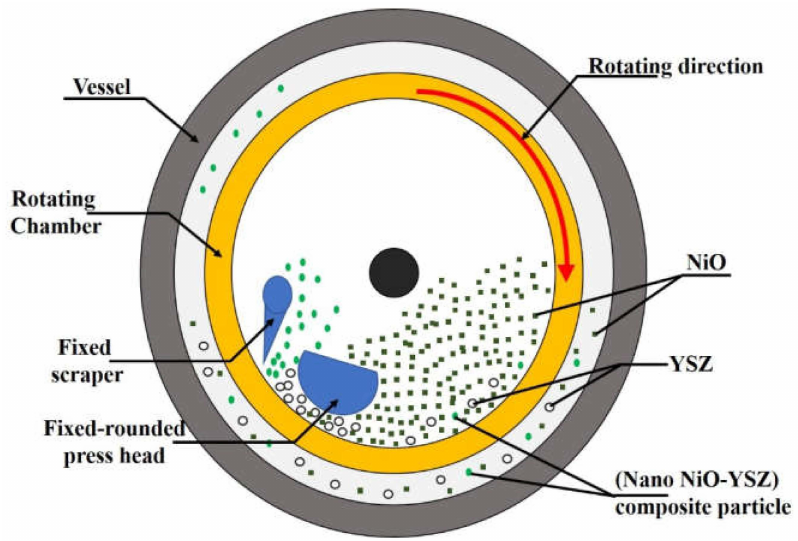
Figure 23. Schematic of the mechanofusion system (redrawn after